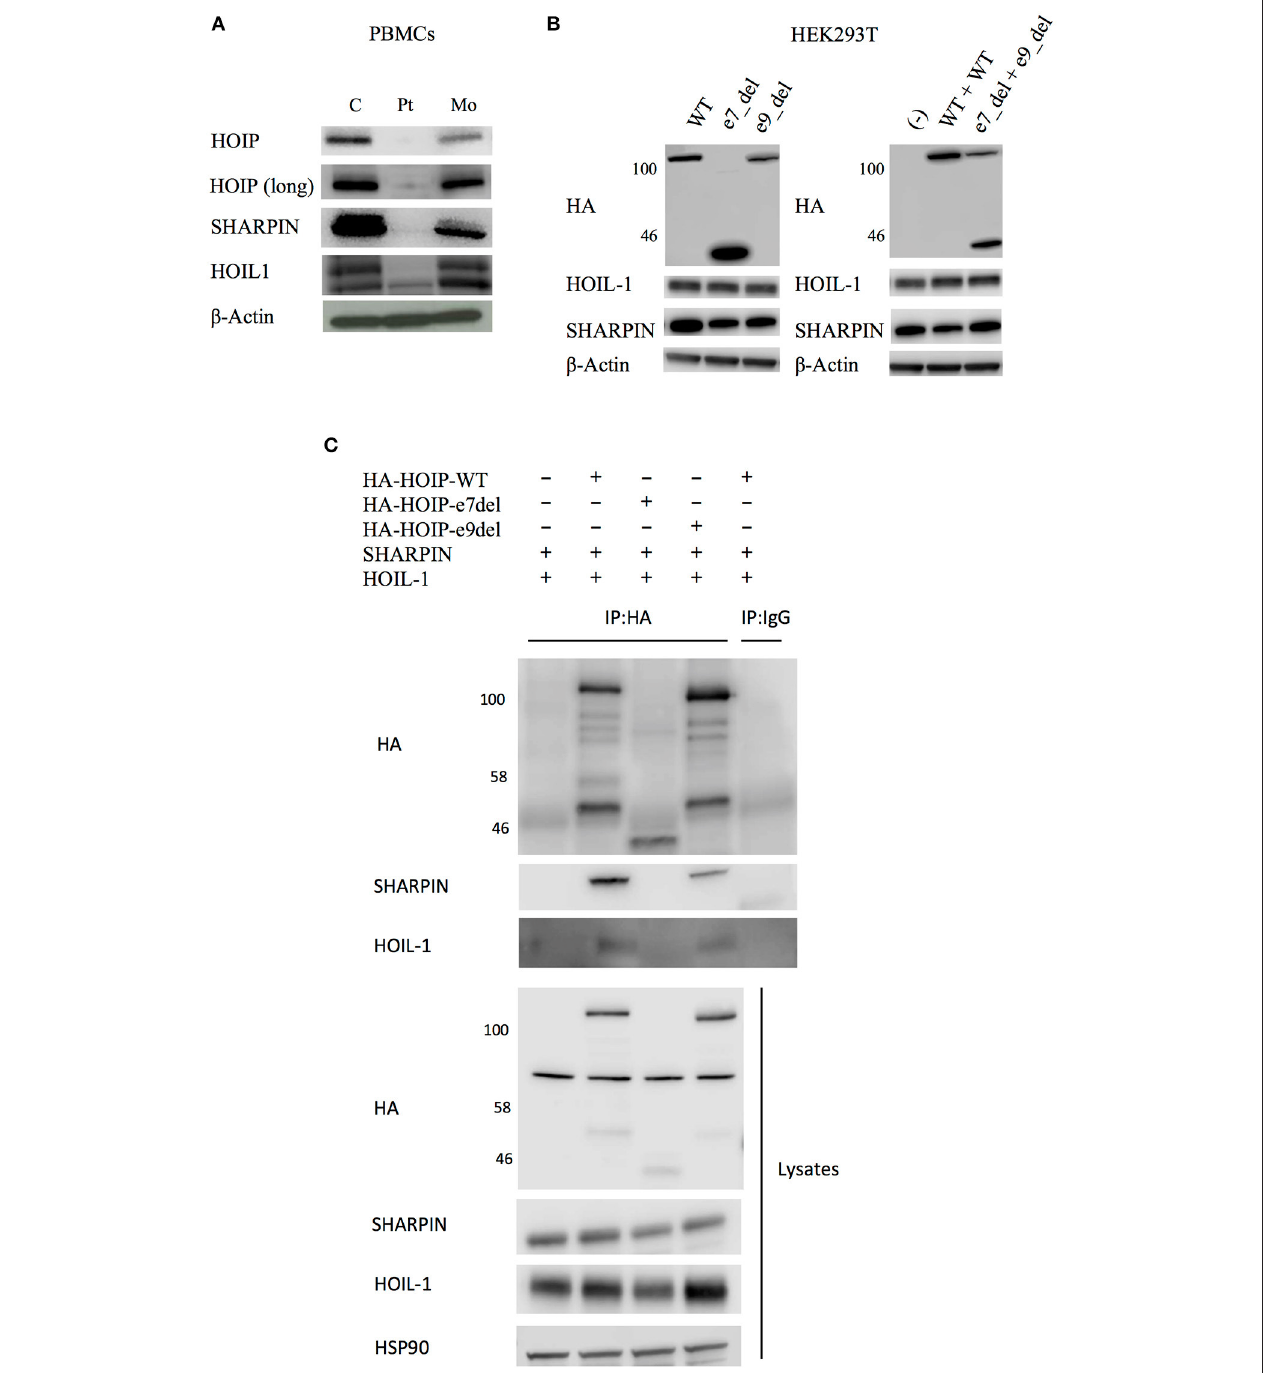
FIGURE 2 | Effects of the identified RNF31 mutations on LUBAC assembly. (A) The expression of LUBAC subunits in PBMCs. HOIP (long) indicates long exposure. C, unrelated age-matched control; Pt, the HOIP deficient patient; Mo, the mother. (B) Overexpression of HA-tagged mutant HOIP plasmids with SHARPIN and HOIL-1 in HEK293T cells. To mimic compound heterozygosity, two mutant plasmids were co-transfected. e7_del and e9_del indicate skipping of exon 7 and exon 9, respectively. (C) Immunoprecipitation of HA-tagged HOIP to assess the LUBAC assembly, in the presence of SHARPIN and HOIL-1 overexpression. of TRIM25 protein is shown to be upregulated in HOIL- that the LUBAC plays a role in regulating antiviral responses via degradation of TRIM25, a positive regulator of type I 1 knock-out and HOIP knock-down mouse embryonic IFN production (15). Specifically, the baseline expression fibroblasts (MEFs) (15). However, we did not observe increased